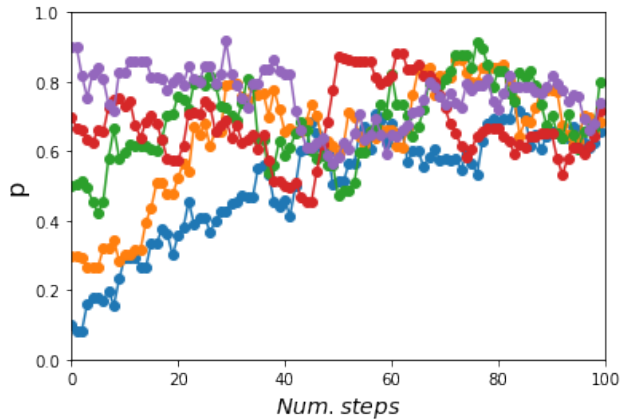
Figure 5. The five Markov Chains used to estimate the posterior distribution. We use p = 0.1,0.3,0.5,0.7,0.9 for starting